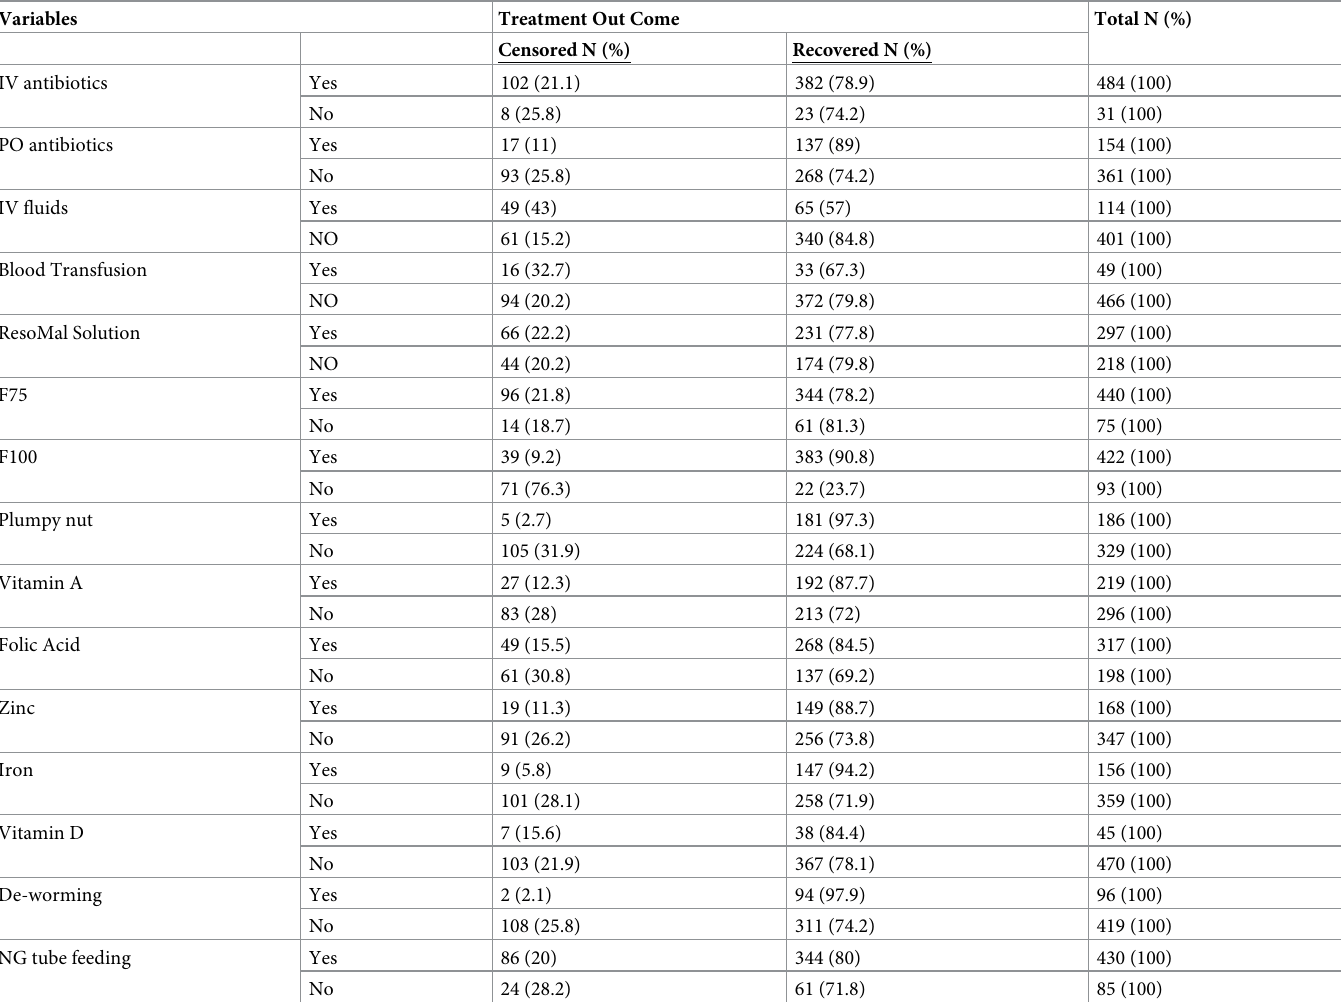
Table 2. Treatments given for under-five children with SAM admitted in SPHMMC from 2012 to 2019, Addis Ababa, Ethiopia (n = 515). Variables